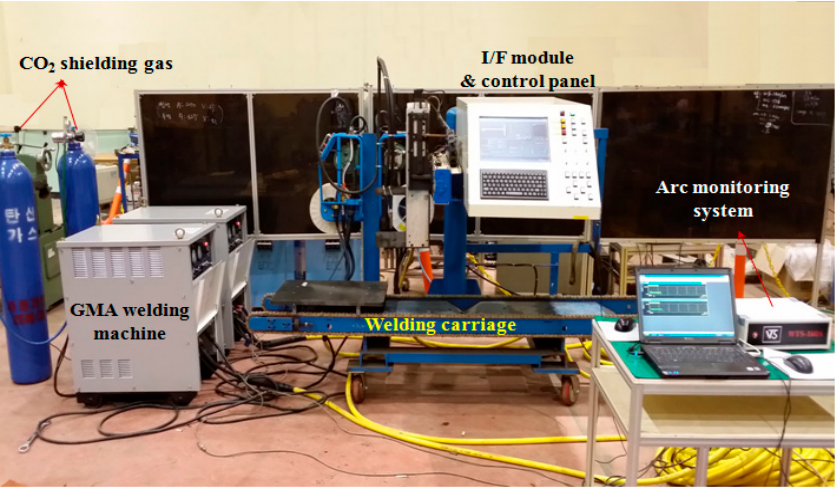
Figure 3. Flux core arc welding equipment.